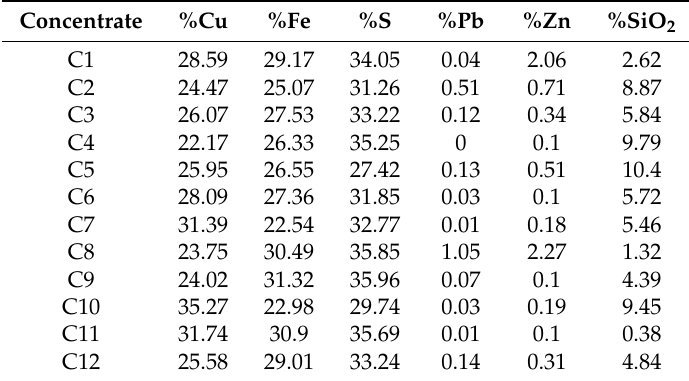
Table 5. Chemical composition of the concentrates studied.